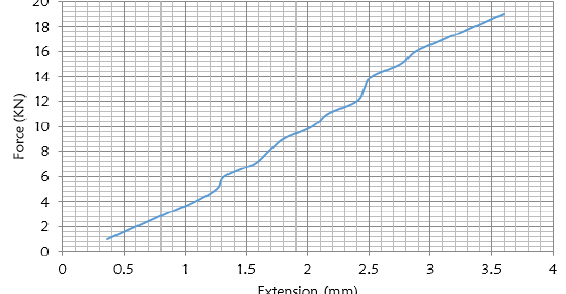
Figure 9: Graph of Load against extension for BLEND A Figure 10: Graph of load against extension for BLEND B